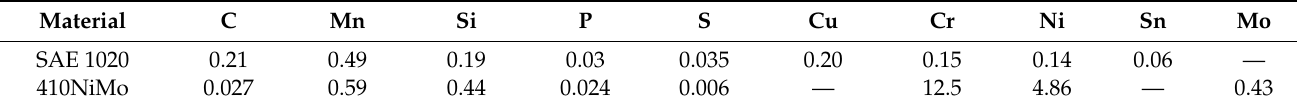
Table 1. Chemical composition of the materials used in